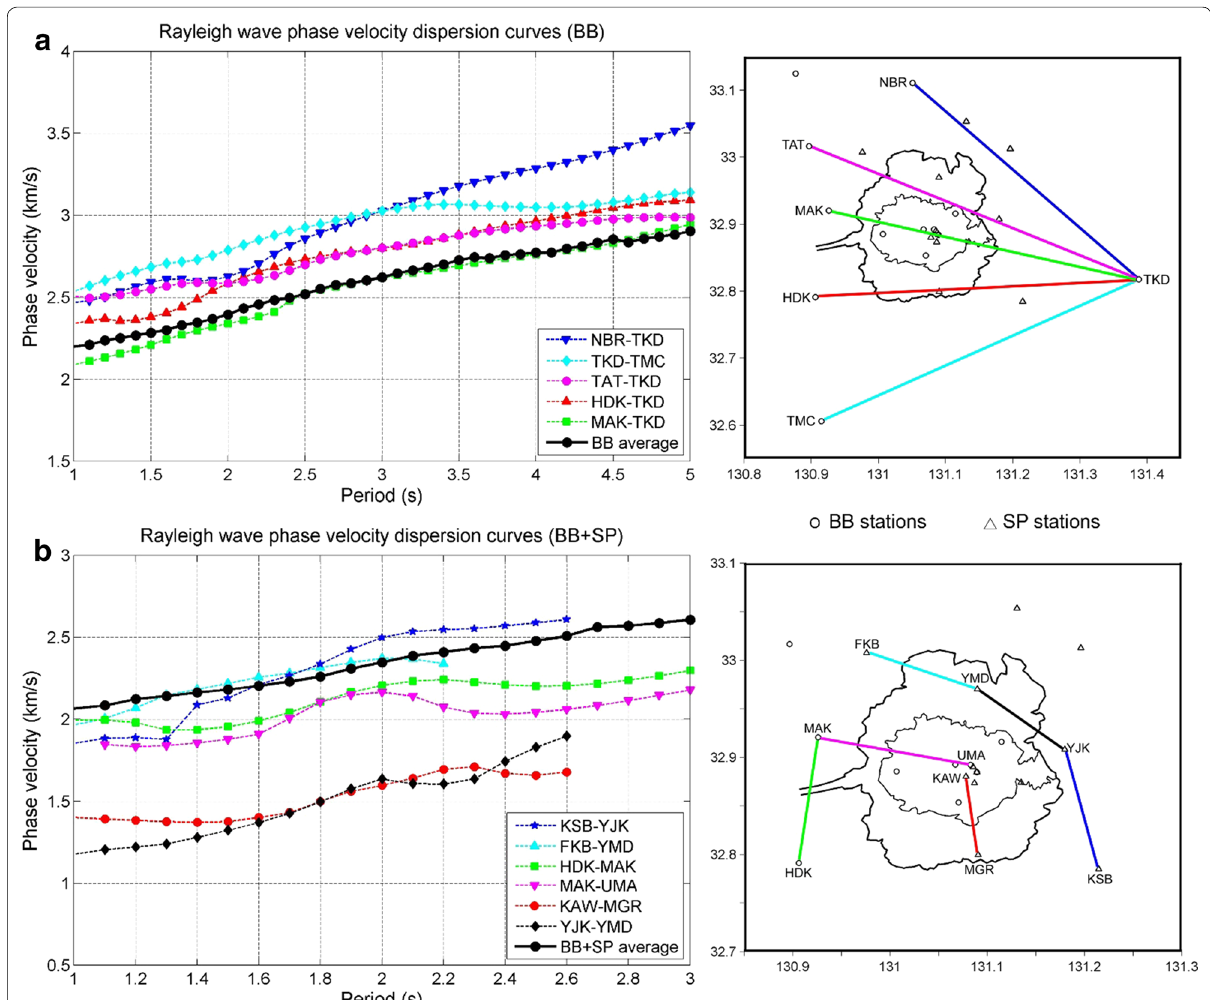
Fig. 8 Comparison of Rayleigh‑wave phase‑velocity dispersion curves of the selected station pairs for different paths: a five BB station pairs with approximate interstation distances of 50 km transect different portions of the study region; and b six BB and SP station pairs with approximate interstation distances of 10 km transect different portions of Aso caldera. The solid black line with circle markers represents the average Rayleigh‑wave phase‑velocity dispersion curve displayed in Fig.